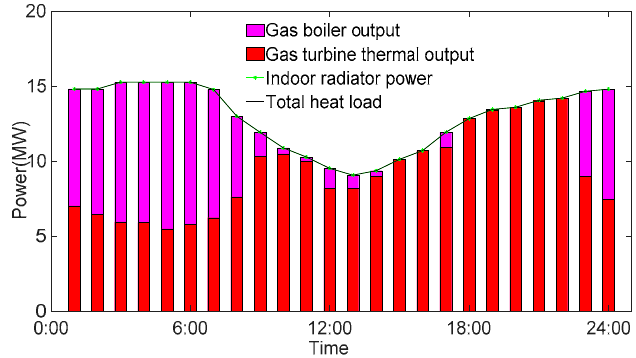
Figure 11. Unit heat output without considering the heat demand envelope.